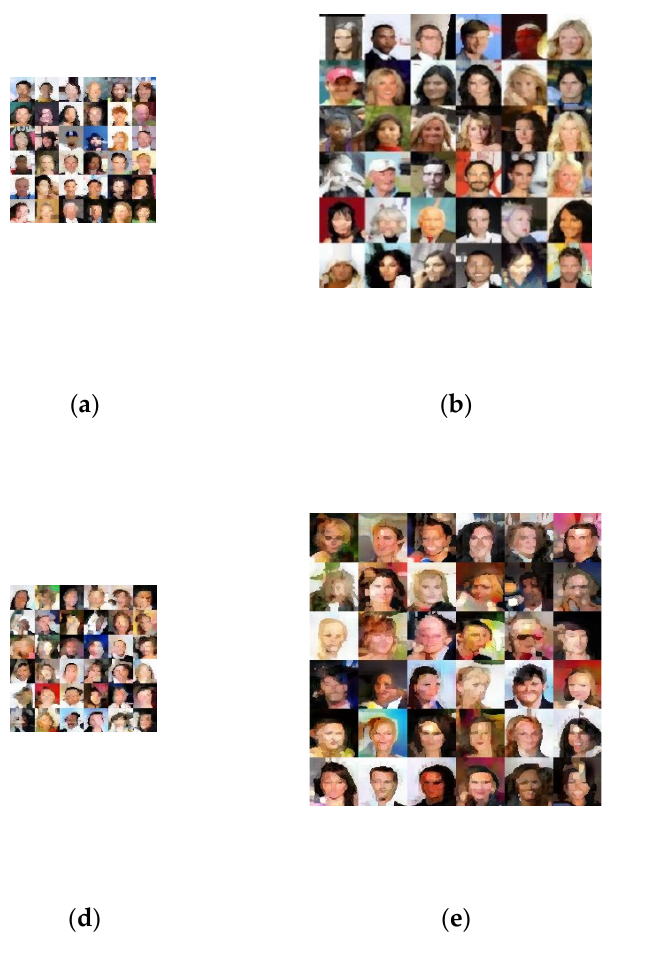
Figure 8. Generated and original samples. ( a ) Features extracted by the second CMS-Encoder unit; size: 32 × 32. ( b ) Features extracted by the first CMS-Encoder unit; size: 64 × 64. ( c ) Original samples; size: 128 × 128. ( d ) Features generated by the first SGAN; size: 32 × 32. ( e ) Features generated by the second SGAN; size: 64 × 64. ( f ) Samples generated by the third SGAN; size : 128 × 128. Table 2. FID of SSGAN and other methods. The results show that the proposed SSGAN outper- forms previous works.